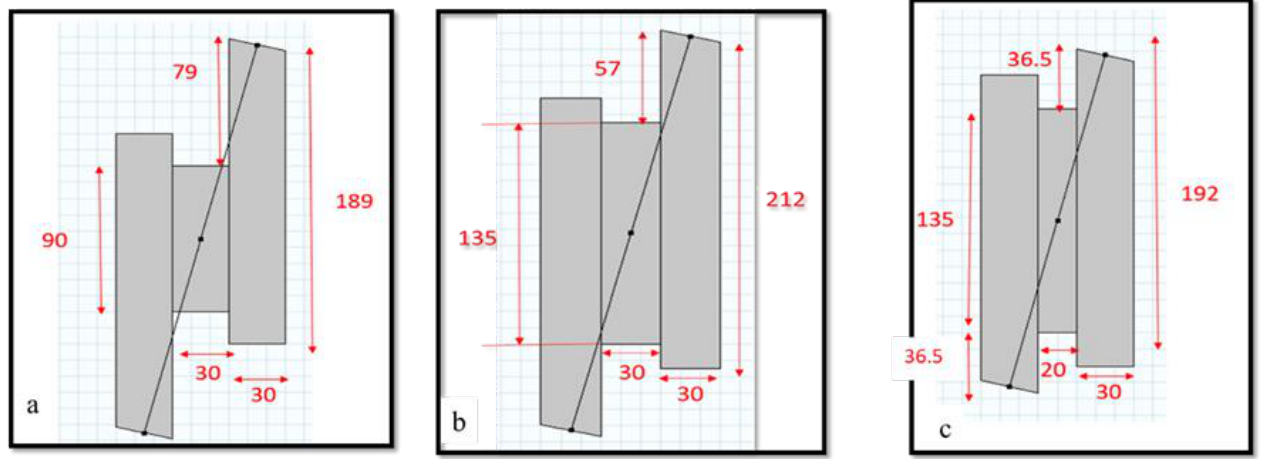
Figure 2. Sample preparation for aspect ratio ( a ) 3.0, ( b ) 4.5 and ( c ) 6.75 for Southern and Radiata